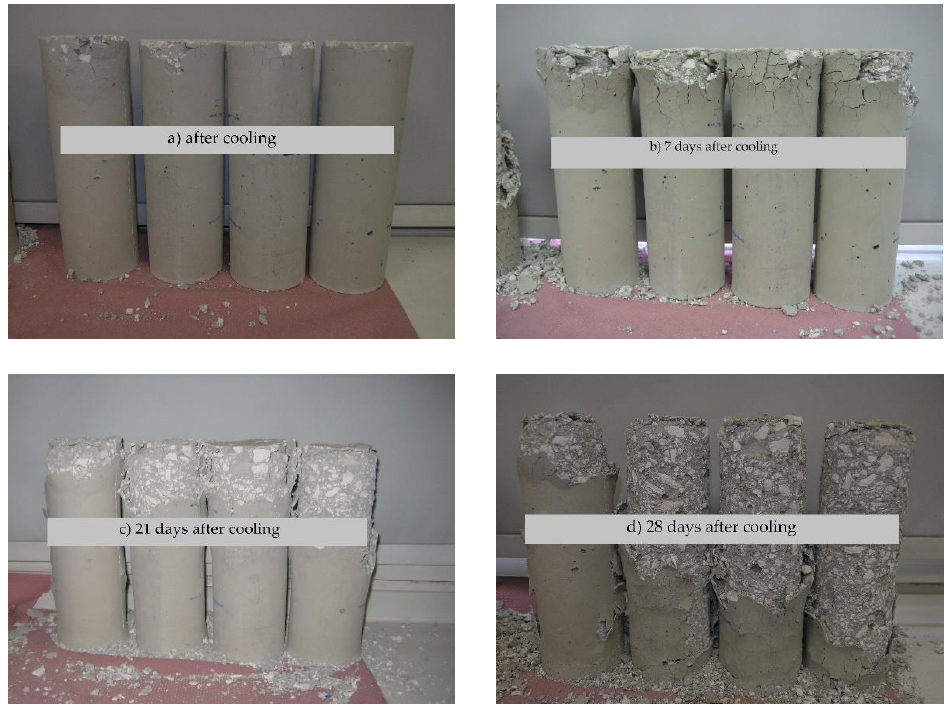
In Figure A2., the degradation of specimens is presented with elapsed time up to 28 days after cooling.